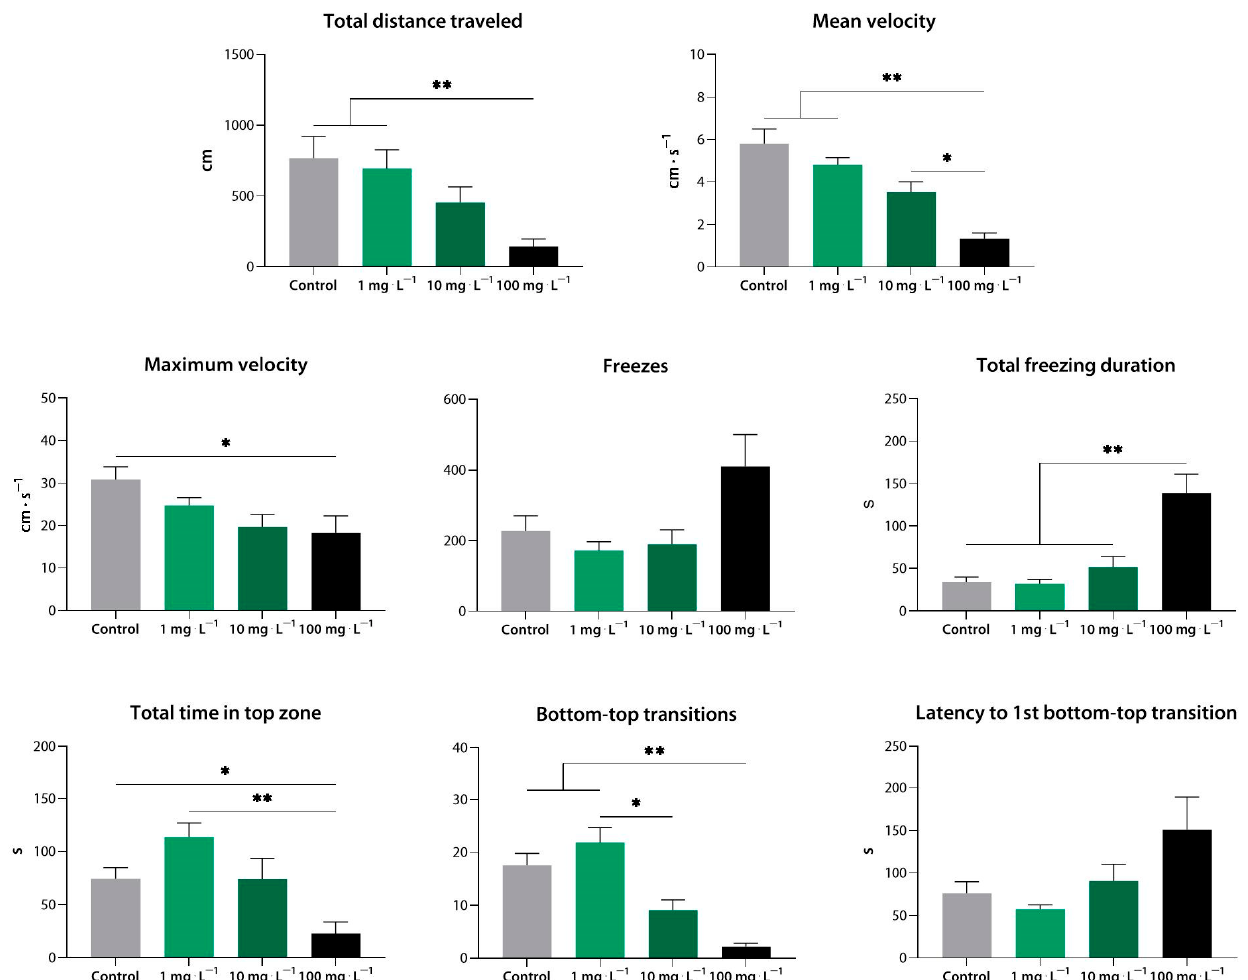
Figure 5. Compound 4 ( 33a ) induces sedation in zebrafish at a range of concentrations, as assessed using the novel tank test. *, p < 0.05; **, p < 0.01.